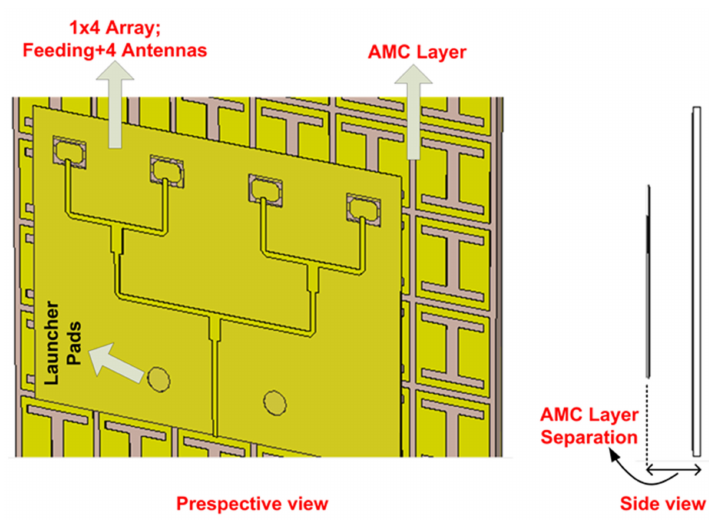
Figure 13. Perspective and side views of the embedded antenna with